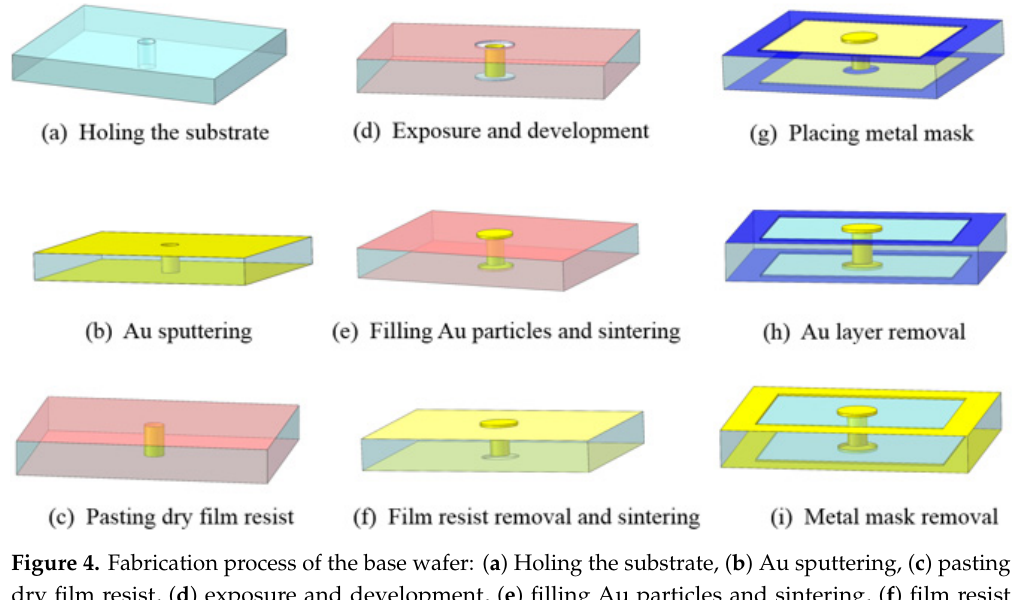
Figure 4. Fabrication process of the base wafer: ( a ) Holing the substrate, ( b ) Au sputtering, ( c ) pasting dry film resist, ( d ) exposure and development, ( e ) filling Au particles and sintering, ( f ) film resist removal and sintering, ( g ) placing metal mask, ( h ) Au layer removal, and ( i ) metal mask removal. Reproduced with permission from [46], published by IOPScience, 2016.